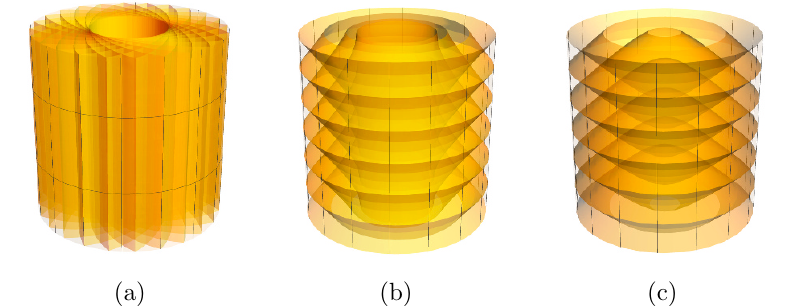
Figure 8. Symmetry-breaking SL(2 ; R ) branes: the worldvolume obtained by smearing (a) the AdS 2 brane along (cid:27) ; (b) the dS 2 brane along (cid:28) ; (c) the H 2 brane along (cid:28) . Note that the smeared H 2 brane (cid:12)lls SL(2 ; R ), and that although the worldvolumes for the smeared AdS are similar, they are foliated di(cid:11)erently and carry di(cid:11)erent two-form (cid:13)uxes ! 2